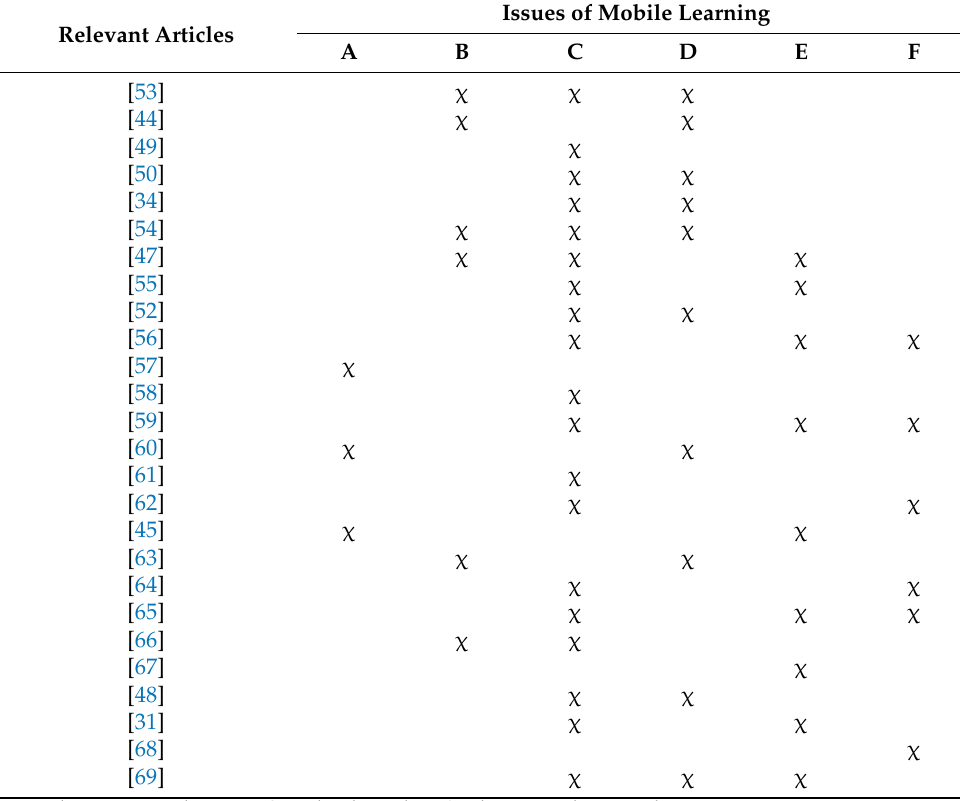
Table 5. Matrix of issues associated with mobile learning. Relevant